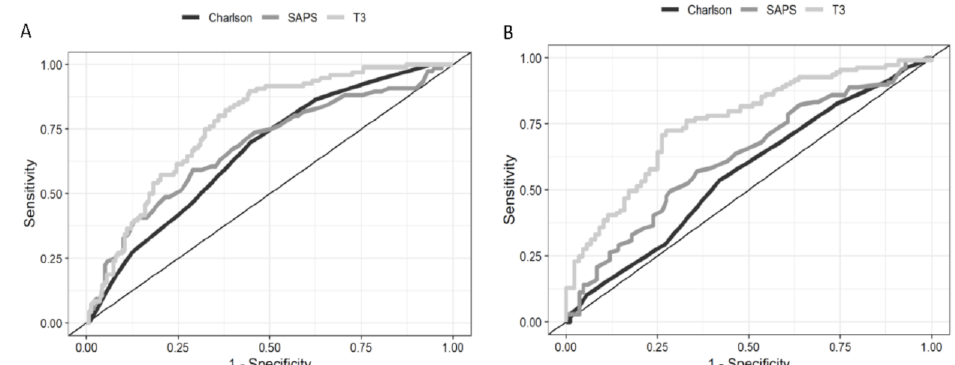
Figure 3. Receiver operating characteristic curves of T3 to predict 28-day mortality. ( A ) The AUC for lower levels of T3 is 0.76 (95% CI, 0.70–0.82). ( B ) ROC curves of T3 to predict the evolution to CCI. The AUC for lower levels of T3 is 0.75 (95% CI, 0.68–0.82). T3: triiodothyronine; ROC: receiver operating characteristic; and AUC: area under the ROC curve.